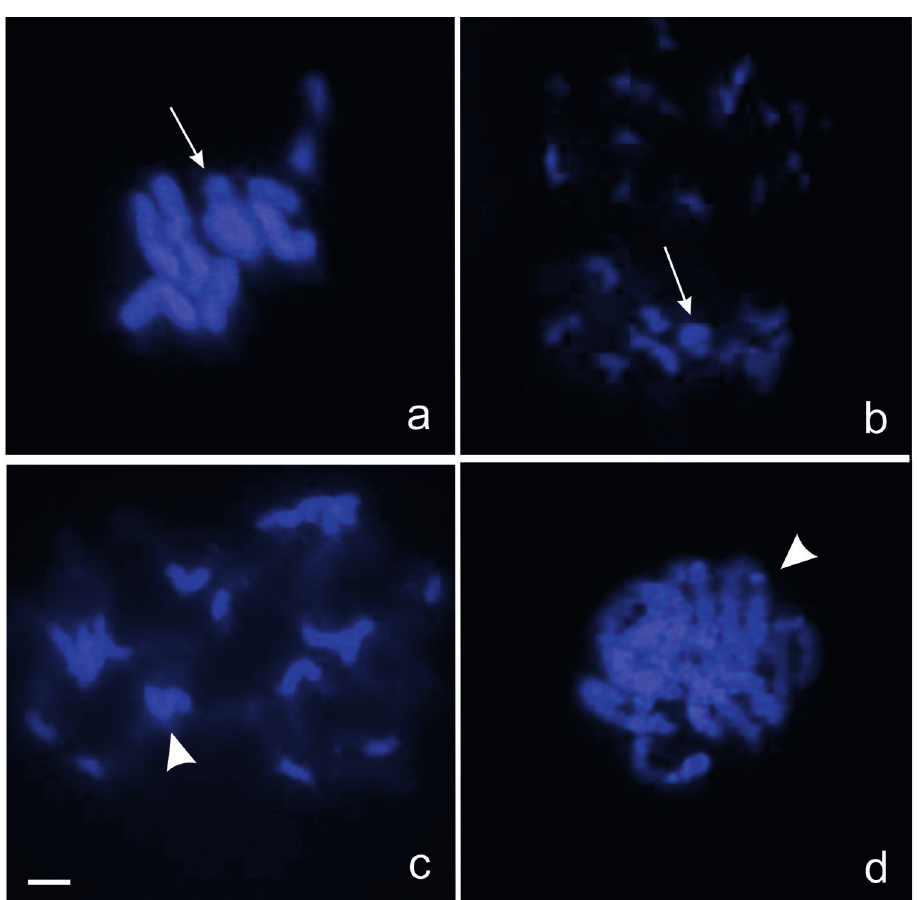
Figure 6. DAPI staining a metaphase I of N. plebejus b metaphase I of N. bozdagus c prophase I nucleus of N. bozdagus d prophase I nucleus of N. plebejus. Arrows show Xy heterochromatic regions, Bars = 5